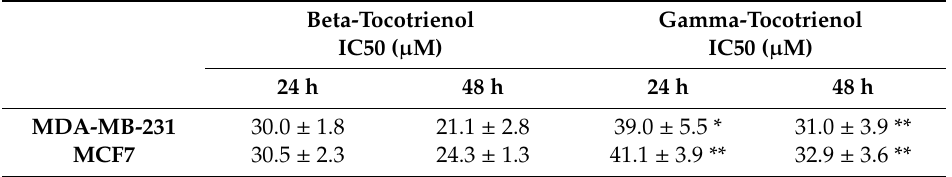
Beta-Tocotrienol IC50 ( μ M)